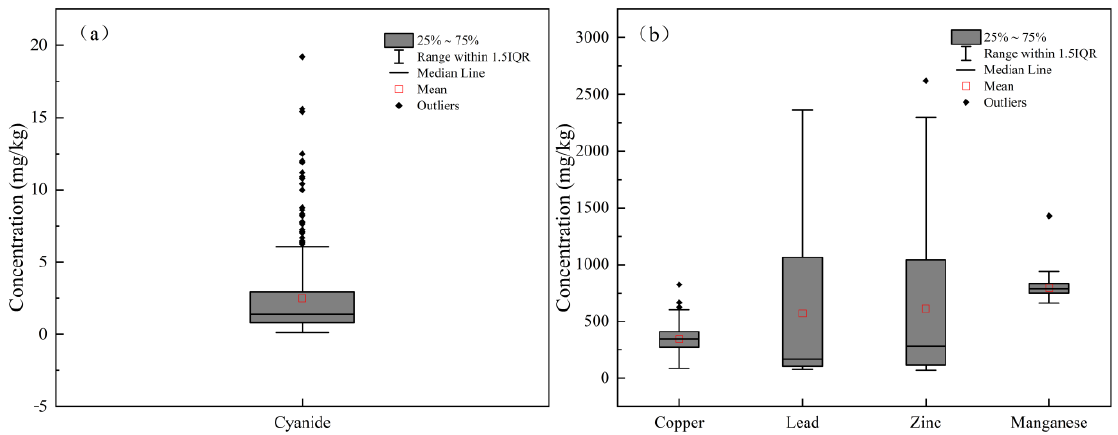
Figure 6. Box diagram of cyanide and heavy metal content analysis in tailings ( a ) cyanide, ( b ) metal ions.